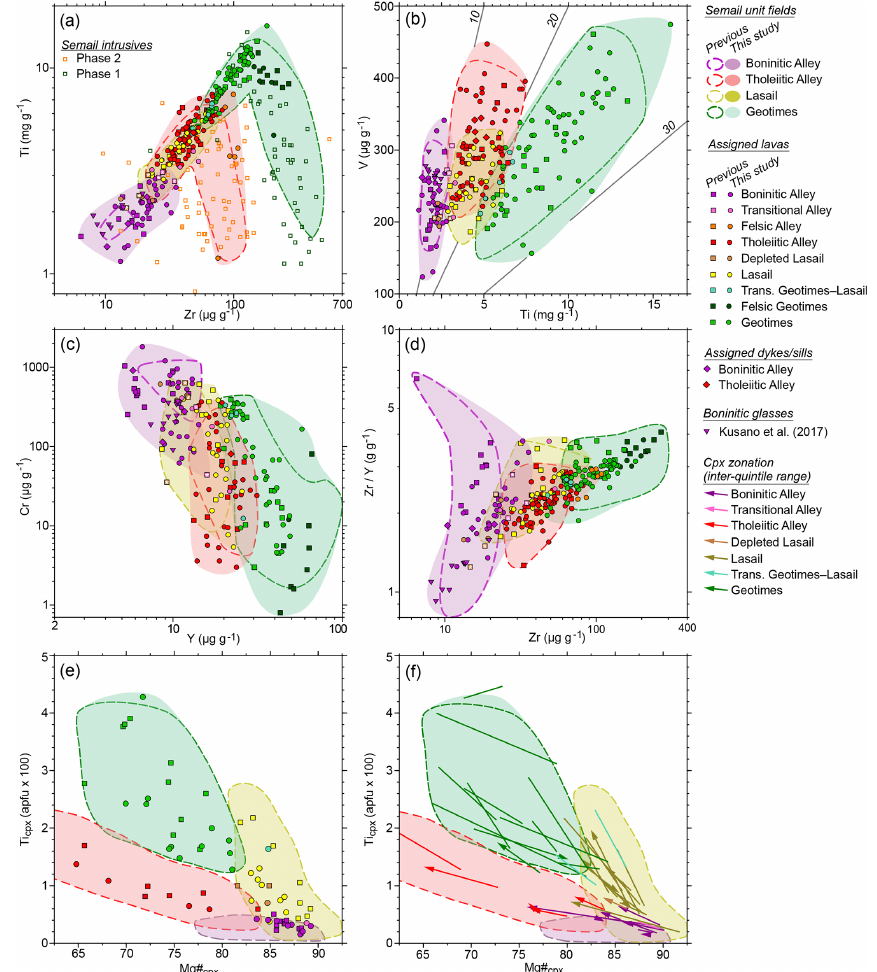
Figure 5. Geochemical unit-discrimination diagrams (anhydrous compositions). Circles: this study. Squares: published analyses re-examined as unknowns (asterisked if assigned differently to the publications; Gilgen et al., 2014, 2016; Kusano et al., 2017). (a) Whole-rock Ti–Zr after Alabaster et al. (1982). (b) Whole-rock Ti–V and Ti / V ratios (grey lines) after Shervais (1982). (c) Whole-rock Y–Cr after Pearce (1980). (d) Zr–Zr / Y after Alabaster et al. (1982). (e) Clinopyroxene median Mg# (molar Mg /( Mg + Fe ) × 100) vs. Ti (atoms per formula unit) for a subset of samples. (f) Clinopyroxene lower and upper Mg# quintile medians with corresponding Ti for the same dataset as in (e) . Dashed lines in (a) – (d) : previous whole-rock unit fields based on stratigraphically defined data for Geotimes (Alabaster et al., 1982; Belgrano and Diamond, 2019; Einaudi et al., 2003; Godard et al., 2006; Kusano et al., 2012), Lasail (Alabaster et al., 1982; Belgrano and Diamond, 2019; Godard et al., 2006; Kusano et al., 2012), Tholeiitic Alley (Alabaster et al., 1982; Kusano et al., 2014), and Boninitic Alley (Ishikawa et al., 2002; Kusano et al., 2014). Volcanic glasses (Kusano et al., 2017) and Semail intrusives (excluding wehrlites; de Graaff et al., 2019; Haase et al., 2016). Dashed lines in (e) and (d) : previous clinopyroxene fields (Alabaster et al., 1982; Belgrano and Diamond, 2019; Gilgen et al., 2014; Kusano et al., 2012). Coloured fields: this